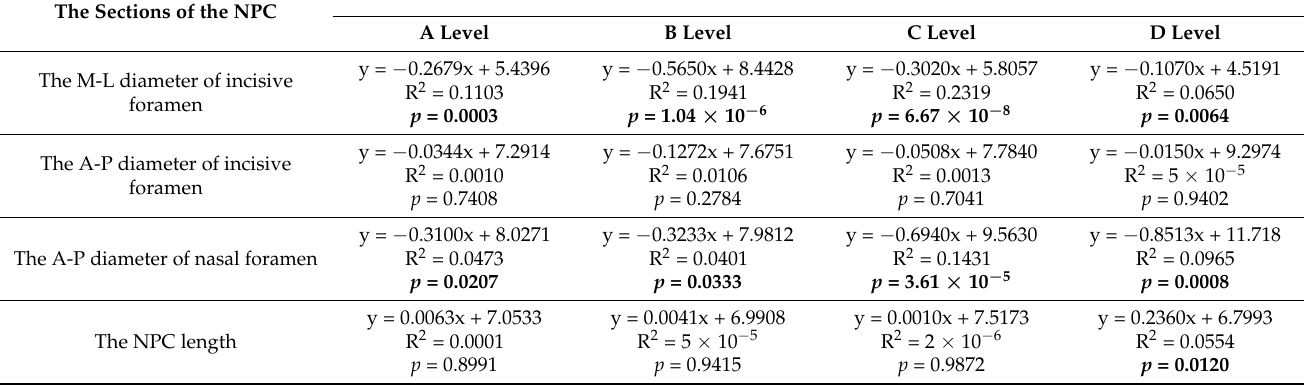
Table 2. The correlation between the diameter at different sections of the nasopalatine canal and anterior maxilla dimensions at predefined portions.